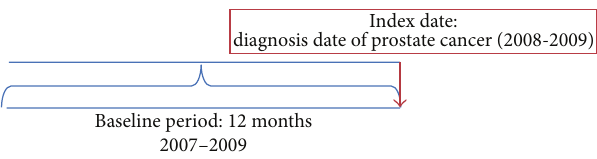
Figure 1: Schematic presentation of study design to examine the relationship between metformin use and cancer stage at